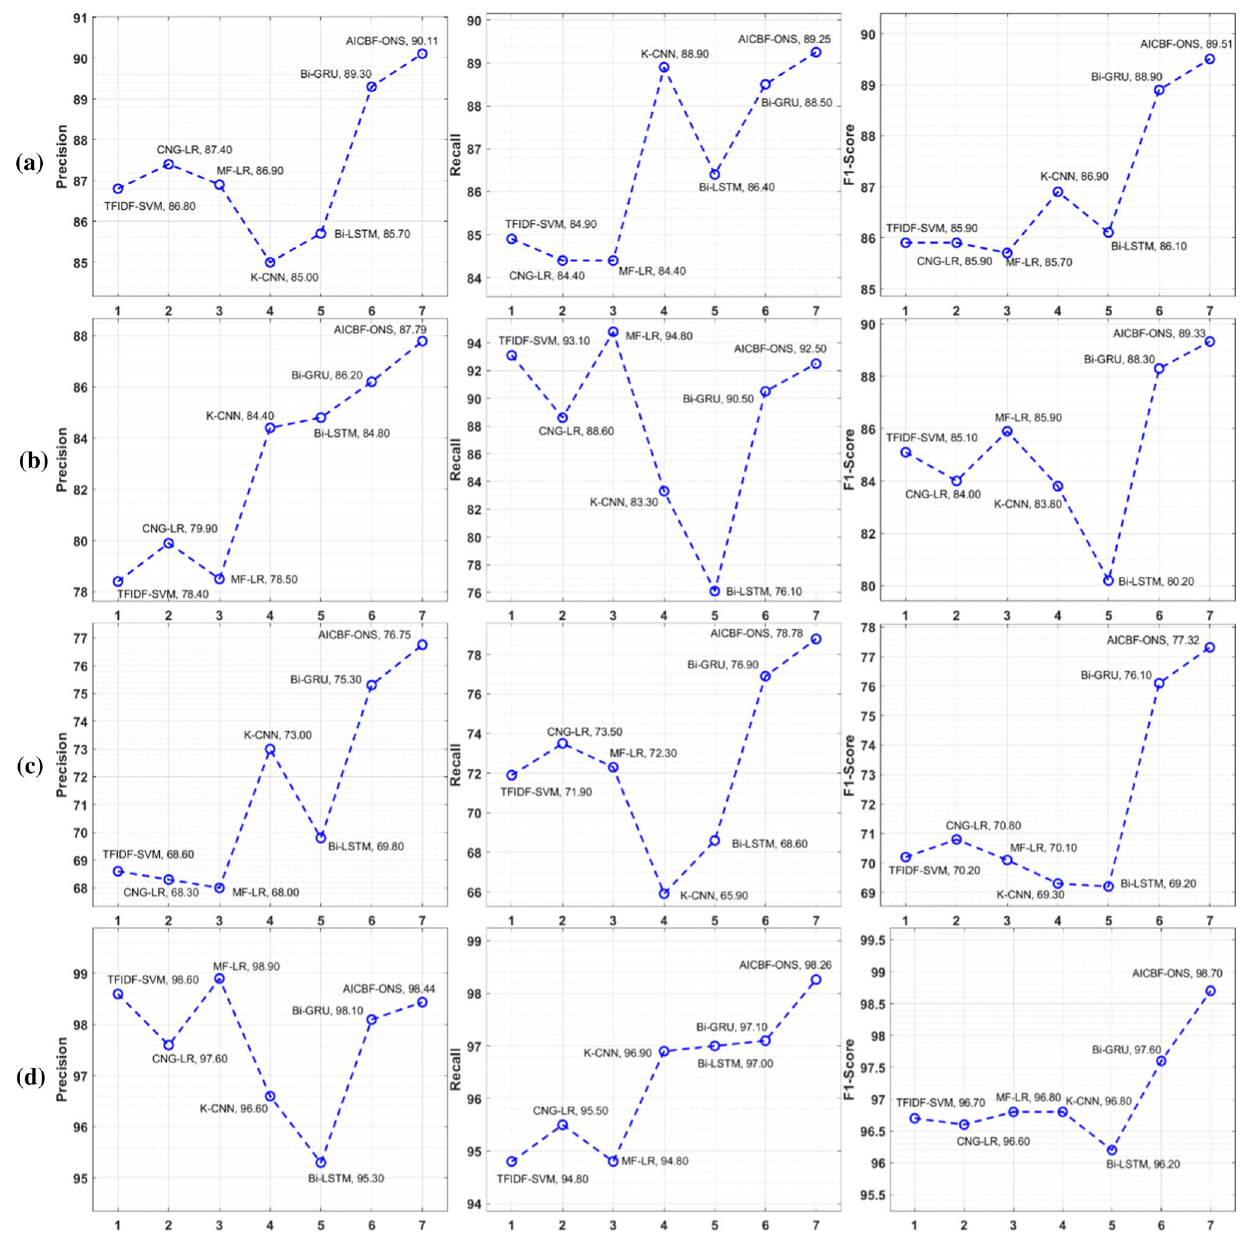
Fig. 6 Results of each class existing with proposed method a Dataset-1 non-cyberbullying b Dataset-1 cyberbullying c Dataset-2 non-cyberbul- lying d Dataset-2